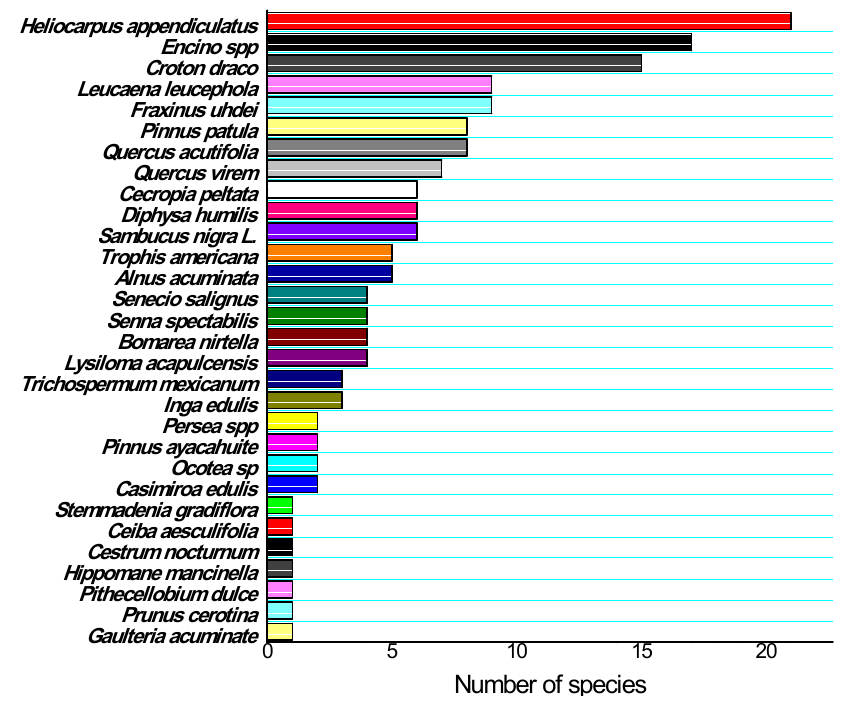
Figure 6. Number of species of the main natural tutors of V. tiliifolia. It is worth mentioning that lianas have negative, positive and neutral effects on tree structure, depending on the species [32–35]. One study suggests that Parthenocissus quinquefolia (L) Planch , which belongs to the Vitaceae family did not